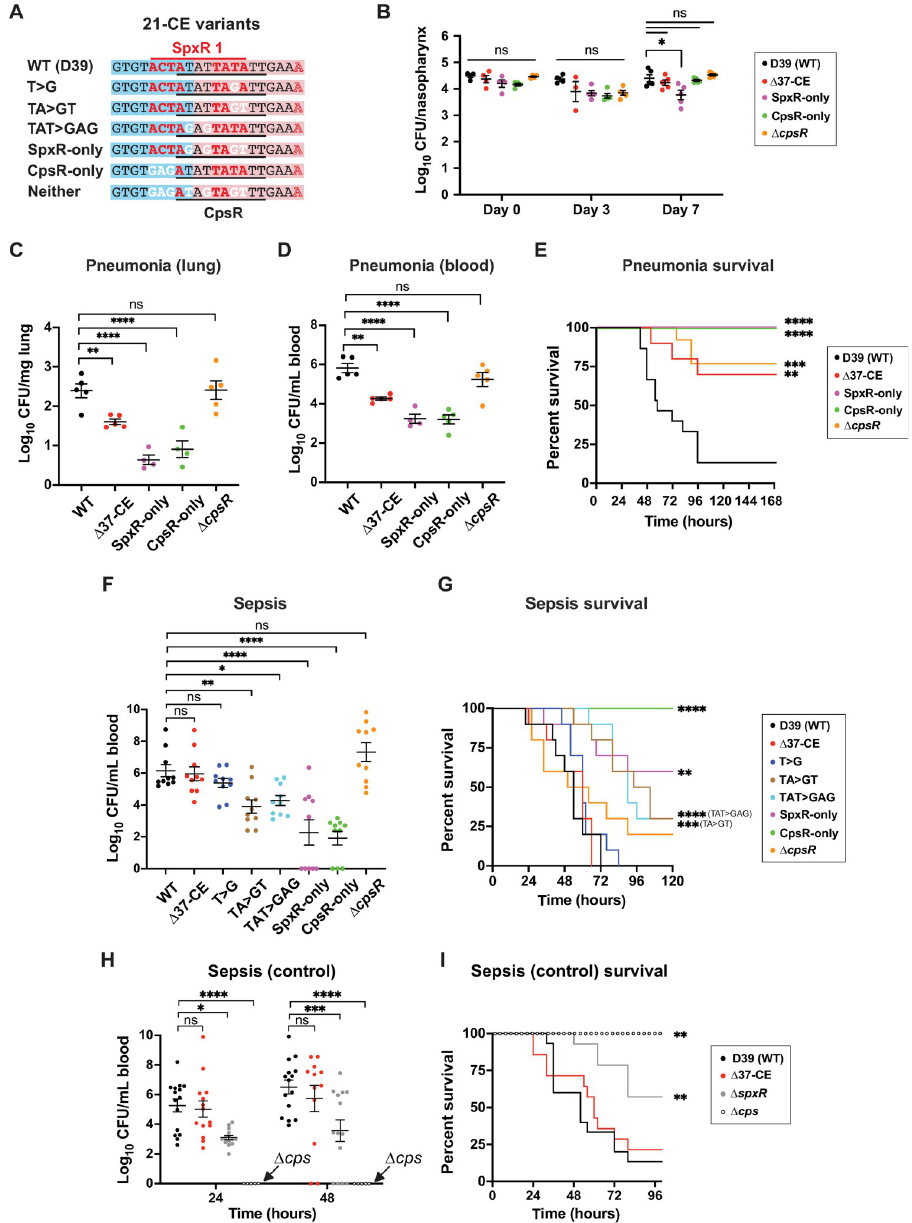
Fig 4. Infection studies. ( A ) Representative 21-CE variants used in infections. ( B ) Colonization model. Mice were infected intranasally with 5x10^5 CFUs of 37/21-CE variants. CFUs were enumerated in nasopharyngeal washes on day 0, 3 and 7. ( C, D & E ) Pneumonia model. Mice were infected intranasally with 5x10^6 CFU. CFUs in lungs ( C) and blood ( D ) were enumerated at 24 hours post-infection. Mouse survival is plotted in ( E ). ( F & G ) Sepsis model. Mice were infected via the dorsal tail vein with 2x10^6 CFU. Blood was withdrawn from the tail vein at 24 and 48 hours for enumeration of CFUs ( F ). Survival of mice from F are plotted in ( G ). ( H & I ) A sepsis model as performed in F with Δ spxR and Δ cps strains. Survival of mice from H are plotted in ( I ). Statistics : For B , a two-way ANOVA was used with Dunnett’s multiple comparison test to determine differences between strains on the same day, and Tukey’s multiple comparison test to determine differences between the same strain on different days. For C and D a one-way ANOVA with Dunnett’s multiple comparison was used. For F and H a two-way ANOVA with Tukey’s multiple comparison test was used. Statistical differences in survival in E , G , and I were determined using the Kaplan-Meier and Log-rank tests for multiple comparisons. ns = not significant; � p � 0.05; �� p � 0.01; ��� p � 0.001; ���� p � 0.0001. Individual data points, the mean and SEM are